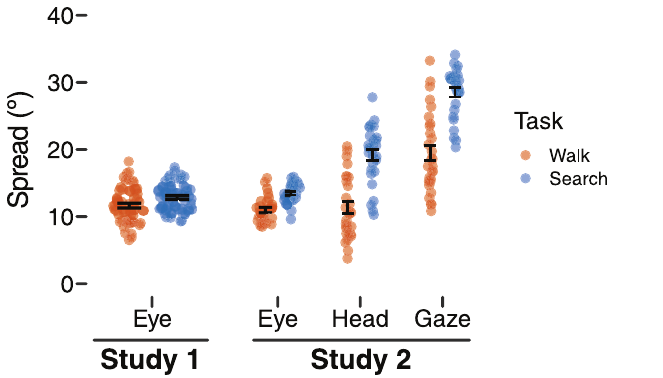
Fig 3. Horizontal spread (standard deviation of rotational position in degrees) in the walking task (orange symbols) versus search and retrieval task (blue symbols). Study 1 shows spread for horizontal eye movements, and Study 2 shows spread for eye movements, head movements, and gaze-in-body (eye-plus-head rotation). Each symbol represents a single participant’s data; points are horizontally offset for visibility. Black error bars are centered on the mean and show ± 1 standard